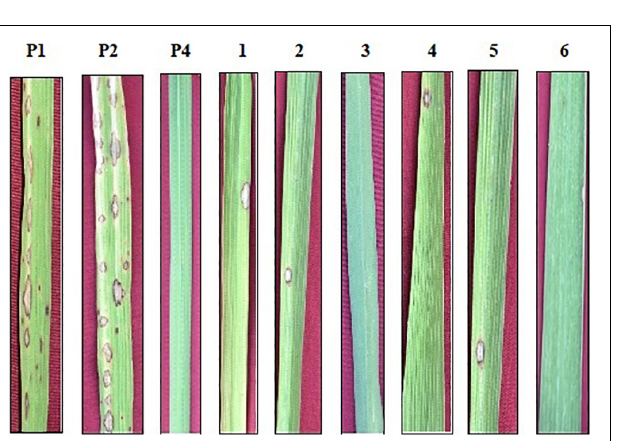
expressed, and the similar mean lesion length ranged from 3.15 ± 0.56 to 4.21 ± 0.49 with the same disease reaction ( xa5 + xa13 , xa5 + Xa21 , and xa13 + Xa21 ) were shown a mean lesion length of 4.58 ± 1.15 with a score of 1–2 (resistant).